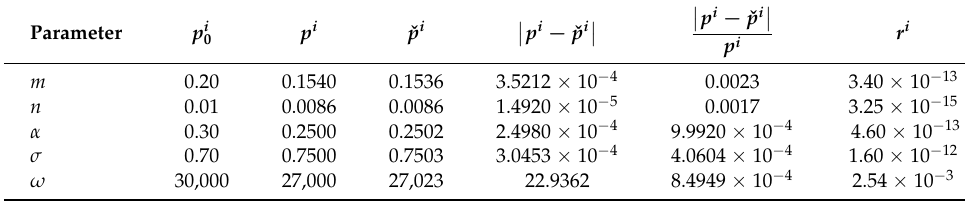
Table 2. Test with Caputo–Fabrizio model